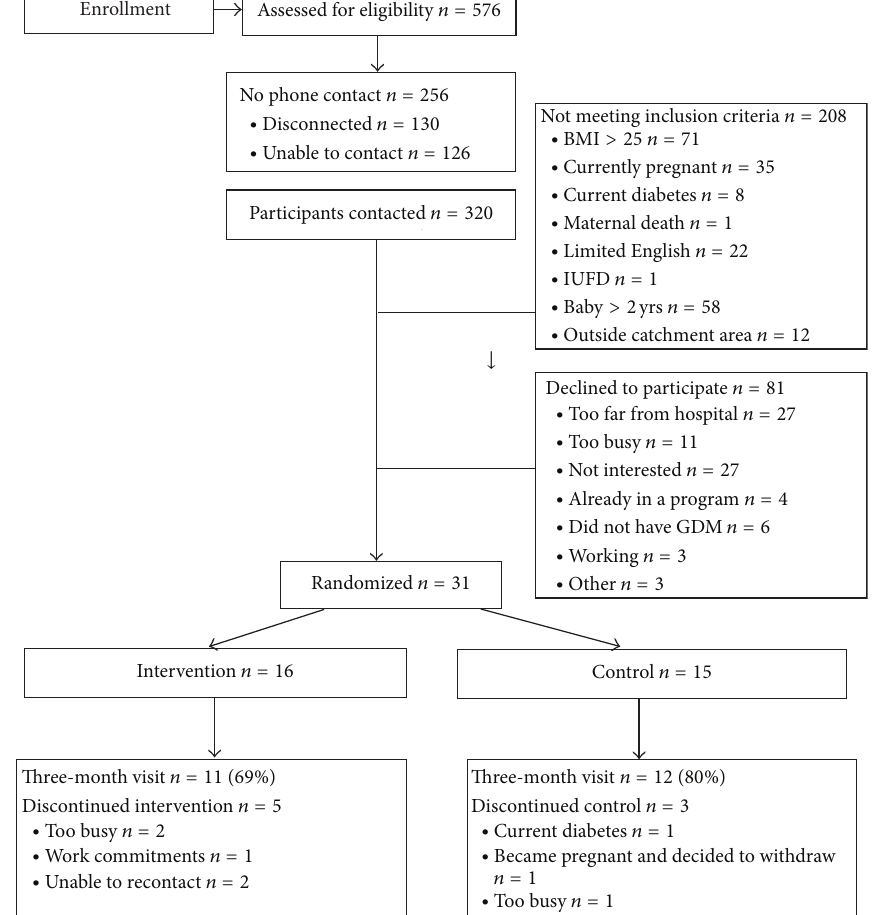
Figure 1: Consort diagram of the